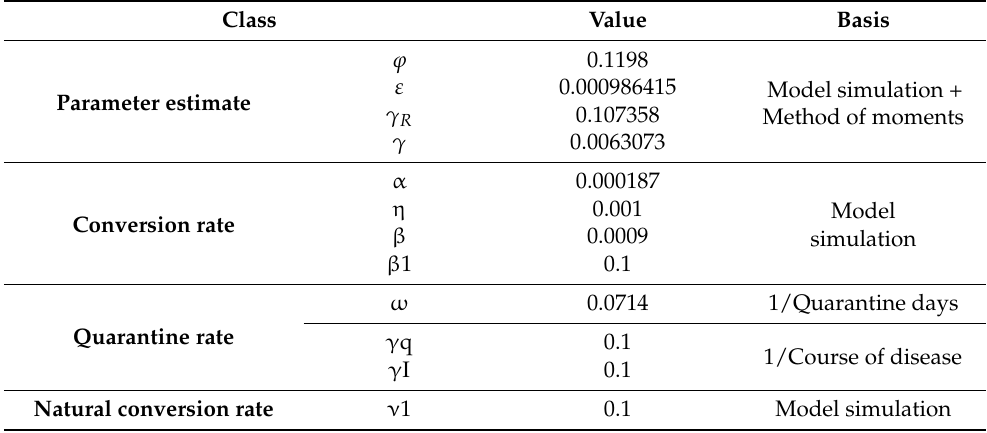
Table 5. Conversion Parameter